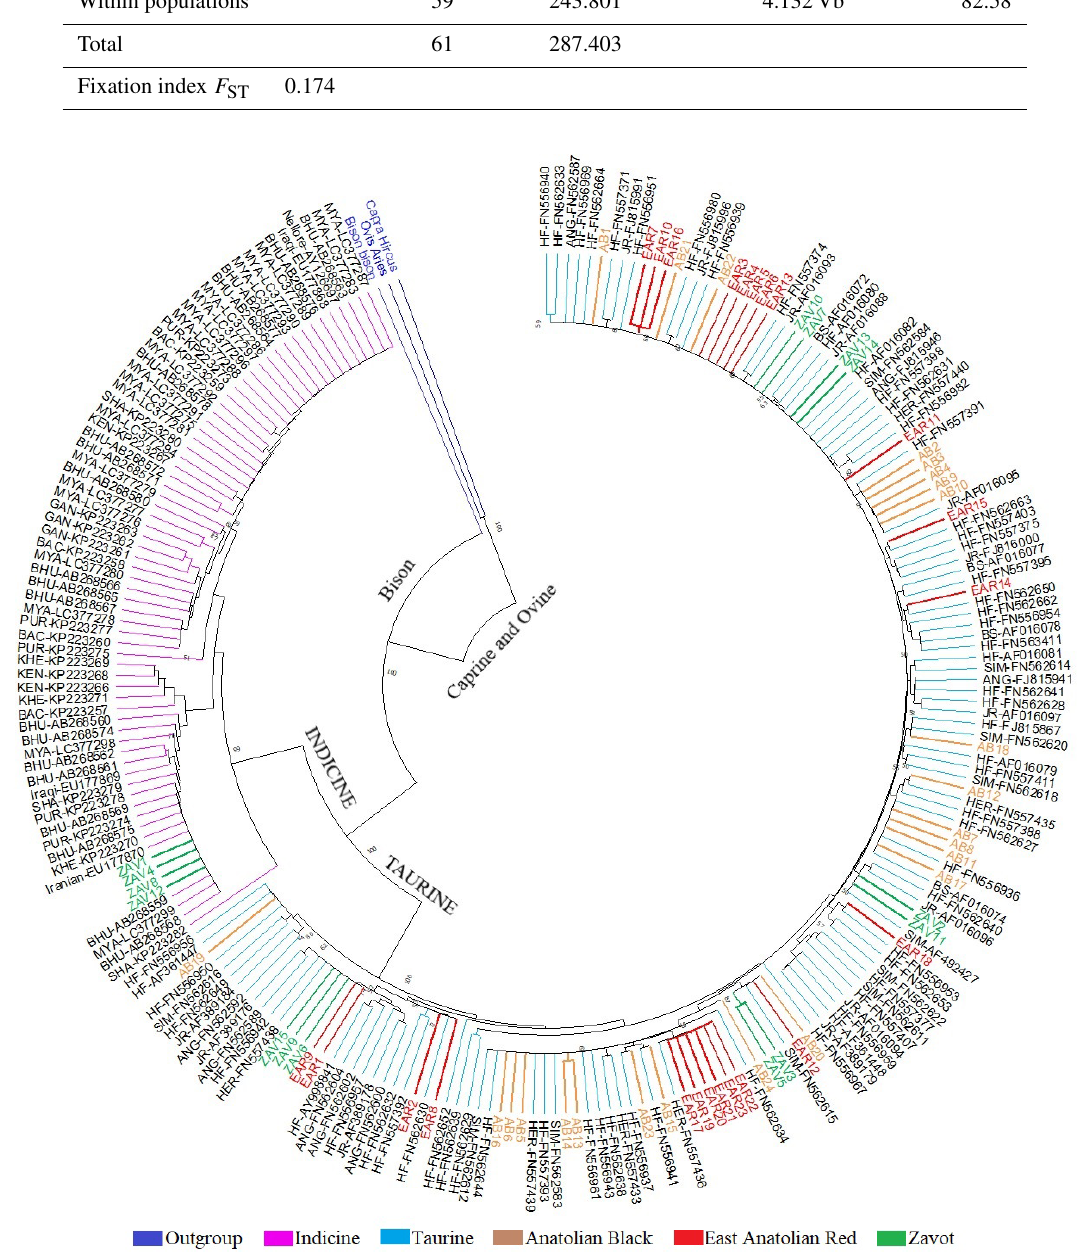
Figure 2. Neighbour joining analysis at the individual level via 450bp mtDNA D-loop region sequences of NCBI database (taurine, indicine and outgroup species) and three native Turkish cattle breeds. The sequences retrieved from NCBI database were renamed based on GenBank number plus breed abbreviation as follows: Aberdeen Angus: ANG, Brown Swiss: BS; Hereford: HER; Holstein Friesian: HF; Jersey: